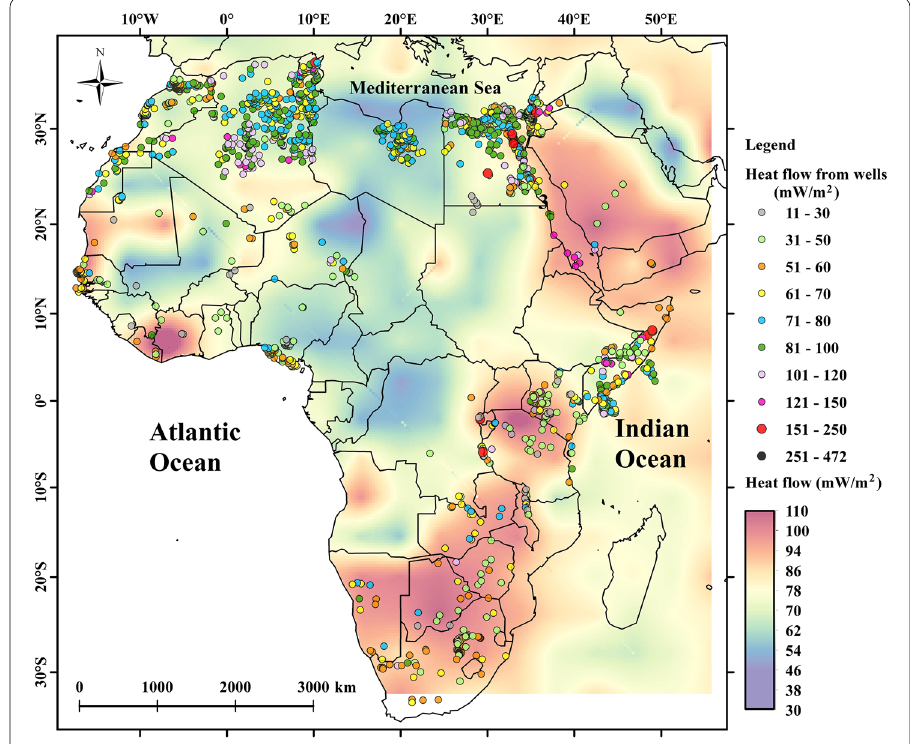
Fig. 5 Heat flow map of Africa estimated from spectral analyses of aeromagnetic data. Colored circles showing heat flow from deep wells in various African countries were plotted to corroborate our